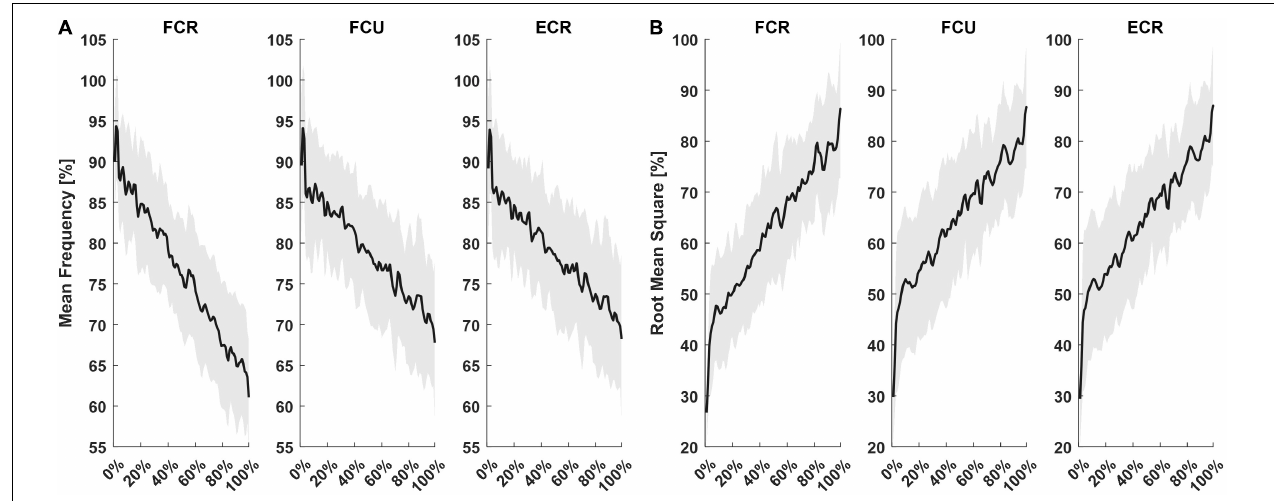
FIGURE 2 | Mean and standard deviation of sEMG outcomes from the three muscles recorded. For each subject, MF (A) and RMS (B) computed for each flexion movement were resampled on 100 points and presented as a percentage of their maximum.